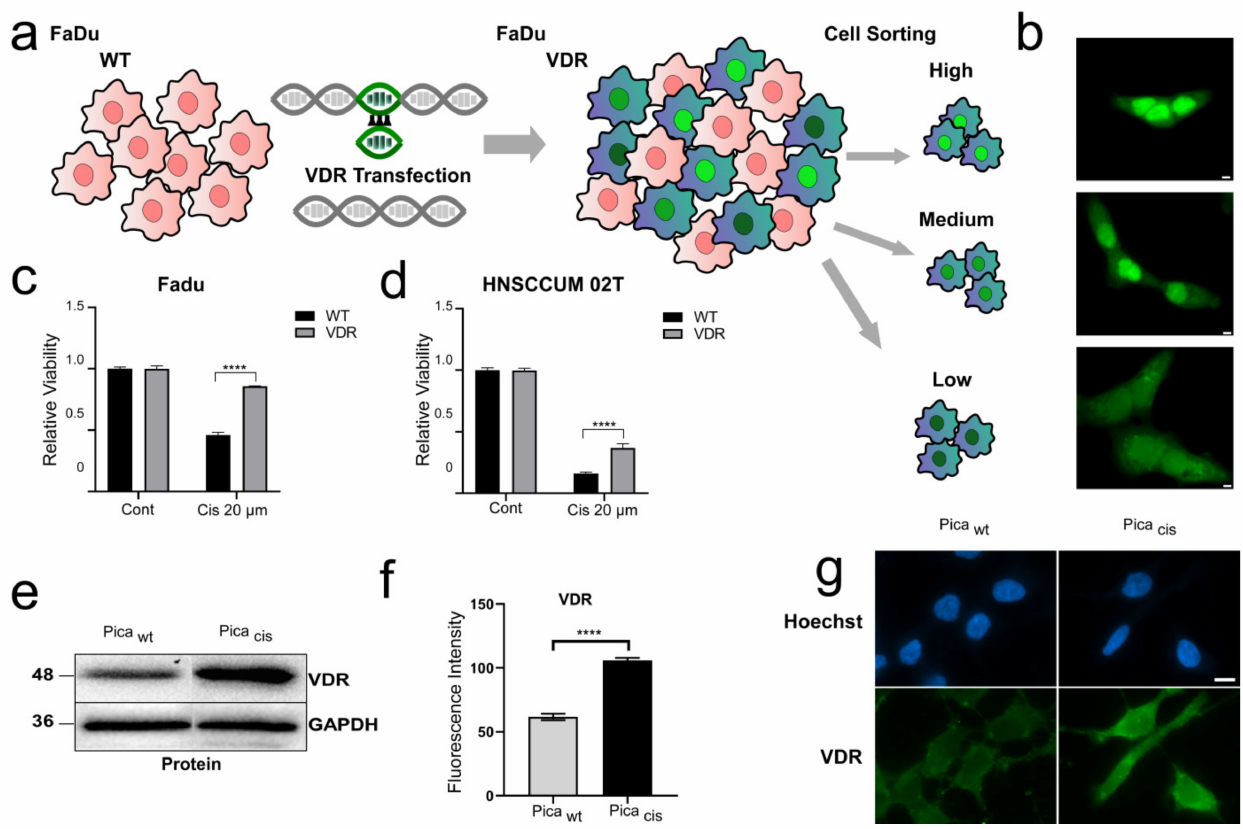
Figure 2. VDR overexpression contributes to cisplatin resistance. ( a ) Generation of VDR- overexpressing HNSCC cell models. Fadu cells were transfected with VDR C-terminally fused to GFP (green). Positive clones were selected using puromycin, and sorted by FACS into high, medium, and low subpopulations. Low-expressing subpopulations were used for experiments. ( b ) Fluorescence-microscopy-visualized VDR expression levels in stable HNSCC (Fadu) cell line. Scale bar, 10 µ m. ( c , d ) Viability assay revealed that VDR-overexpressing Fadu cells ( c ) and HNSCCUM-02T cells ( d ) are more resistant to cisplatin treatment. Cells were treated with 20 µ M cisplatin for 72 h, and viability was measured and normalized to untreated controls (Cont). **** p < 0.0001. ( e ) Overexpression of VDR in resistant Pica CIS versus sensitive (Pica WT ) cells was demonstrated by immunoblot analysis. GAPDH served as loading control. ( f , g ) Immunofluores- cent staining confirmed overexpression of endogenous VDR protein in cisplatin-resistant Pica cells (Pica cis ). VDR expression was automatically quantified using the high-content screening platform Array Scan VTI. **** p < 0.0001. ( g ) Fluorescence-microscopy-visualized VDR overexpression in Pica cis cells. Cells were stained with specific fluorescent VDR Ab (green), and nuclei marked with Hoechst (blue). Scale bar, 10 µ m. VitD-dependent sensitization of cancer cells to cisplatin-induced genotoxicity was inde- pendently verified by a DNA damage assay quantifying γ H 2 AX damage foci (Figure 3d–f). Here, cisplatin-induced DNA damage events were significantly increased by VitD